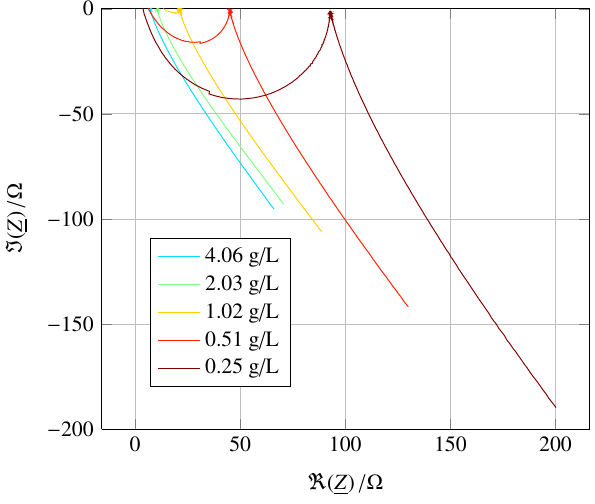
Figure 12. Dependence of the IS on detergent concentration.